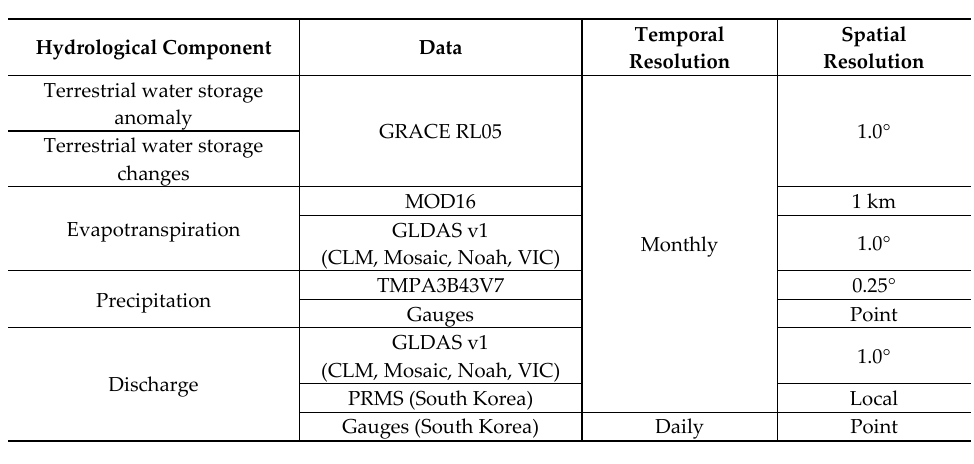
Table 2. The data characteristics used in this study.